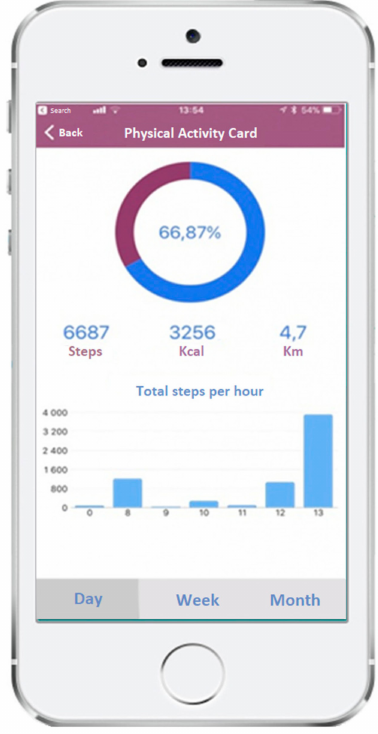
Figure 3. “MySNS Carteira” app—“Physical Activity